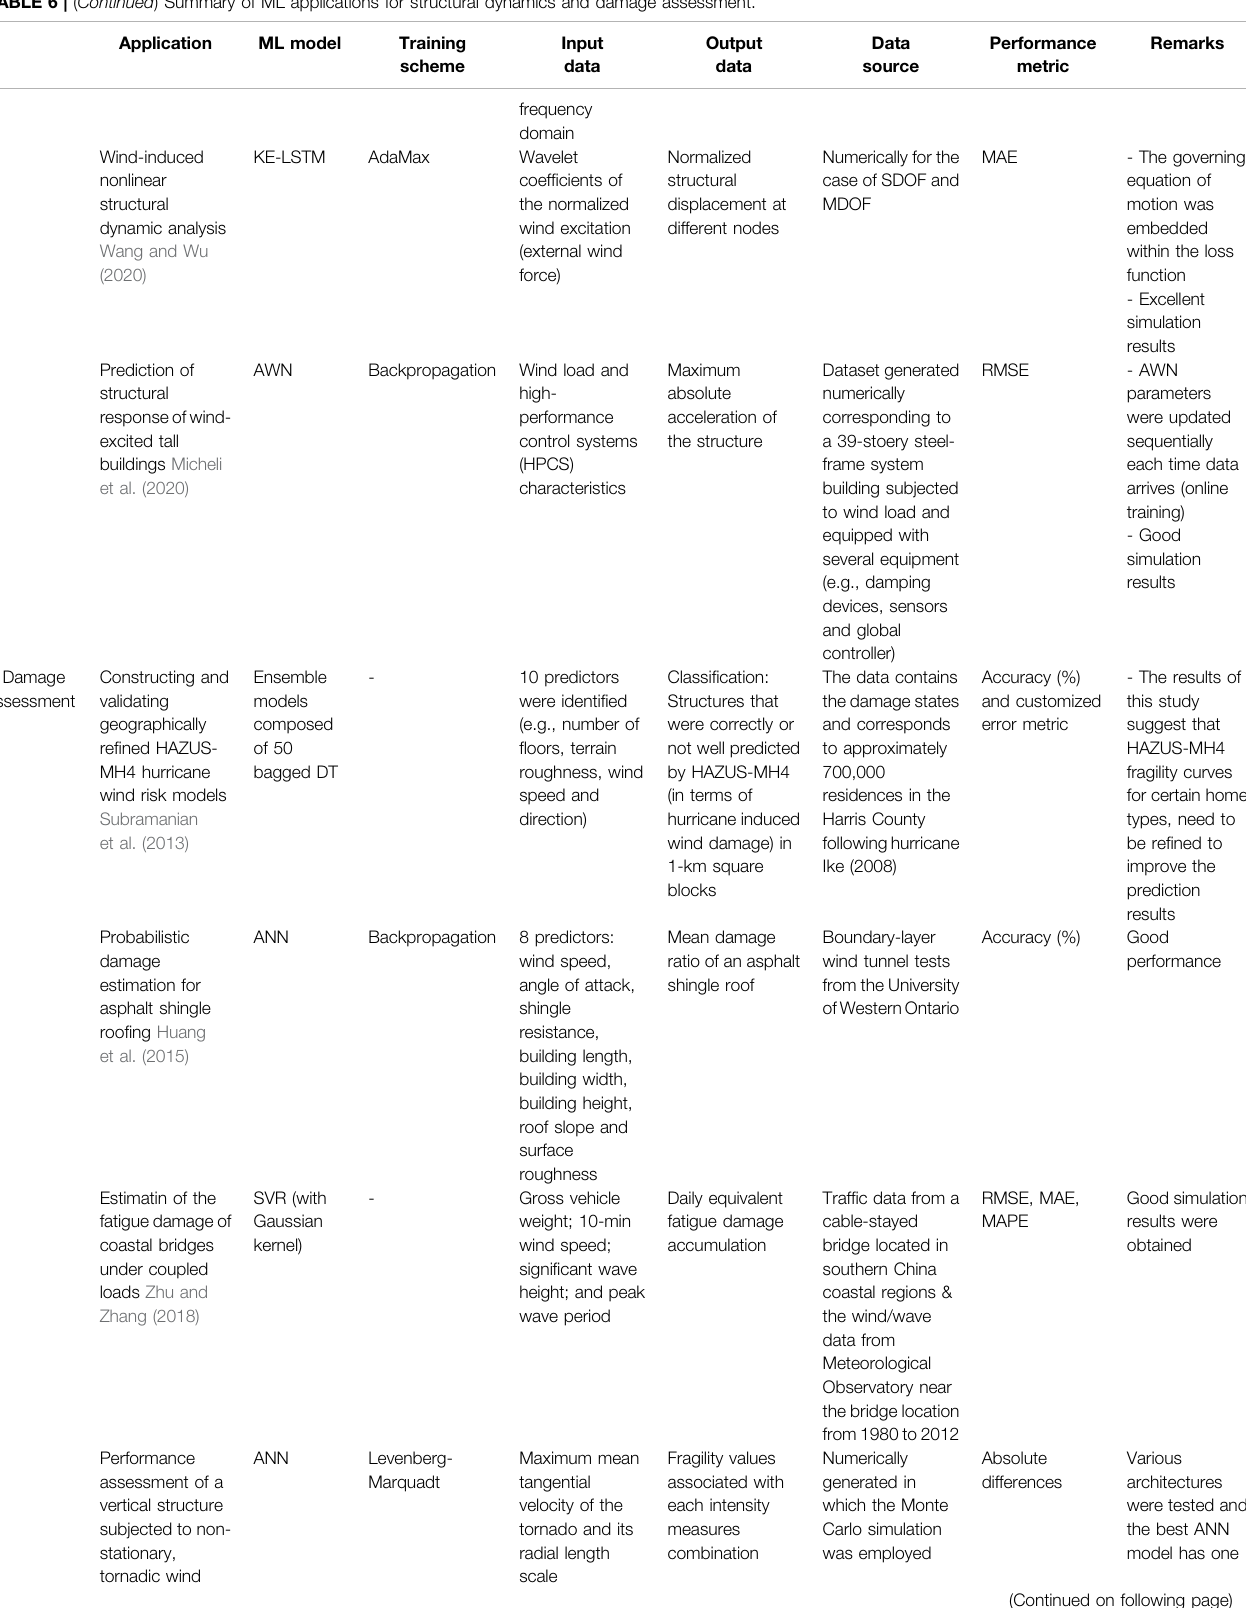
TABLE 6 | ( Continued ) Summary of ML applications for structural dynamics and damage